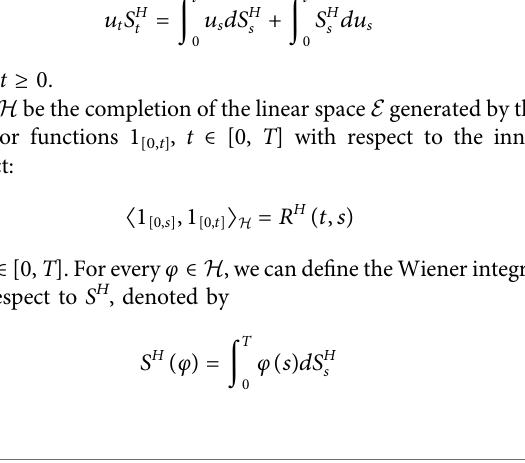
Frontiers in Physics |